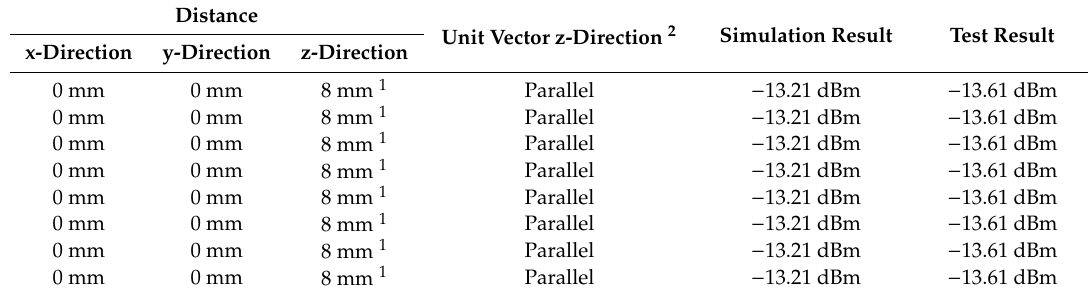
Table 2. Comparison of modeling and unit-level experimental results in the alignment tolerance area. Distance Unit Vector z-Direction 2 Simulation Result Test Result x-Direction y-Direction z-Direction − 13.21 dBm